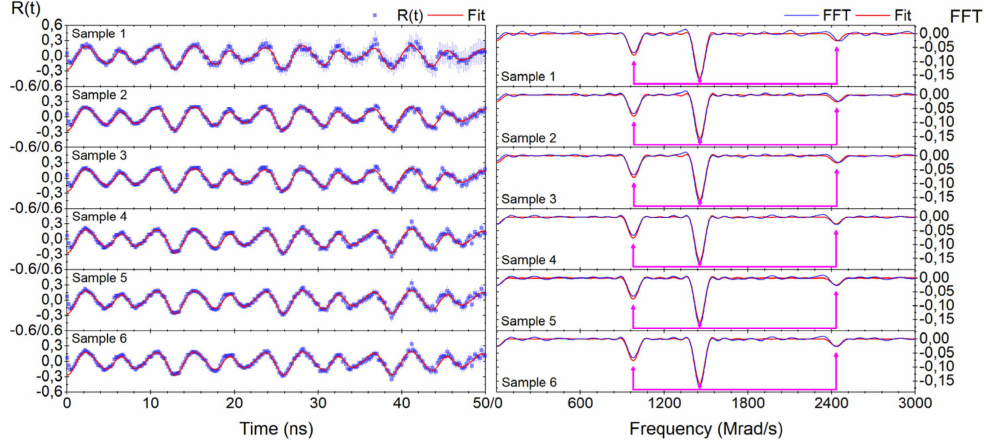
Figure 6. ( left ) R(t) graph and ( right ) corresponding FFT spectrum of the first six of the 13 different e − γ TDPAC measurements of 181 Ta(TiO 2 ). The additive constant is 0.0187. The TDPAC probe used is 181 Hf → 181 Ta, with the raw TDPAC spectrum (from the coincidence searches on the detectors) processed and converted into R(t) observables [blue curves in the R(t) and the corresponding FFT graphs] by Interlude TM [see Equations (2)–(5)]. The R(t) signals are then fit by using the Gfit19 TM program [see red curves in R(t) and the corresponding FFT graphs]. For clarity, we show only the first 50 ns on the R(t) graph because shorter coincidence searches of e − γ rays are less noisy and thus more statistically significant than longer coincidence searches.